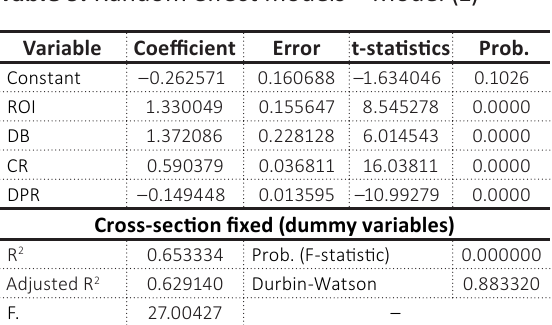
Table 9. Random effect models – Model